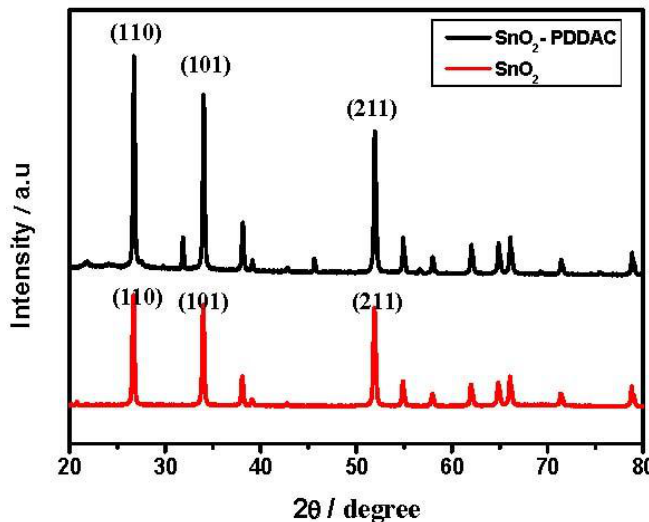
and SnO -PDDAC film. 2 2